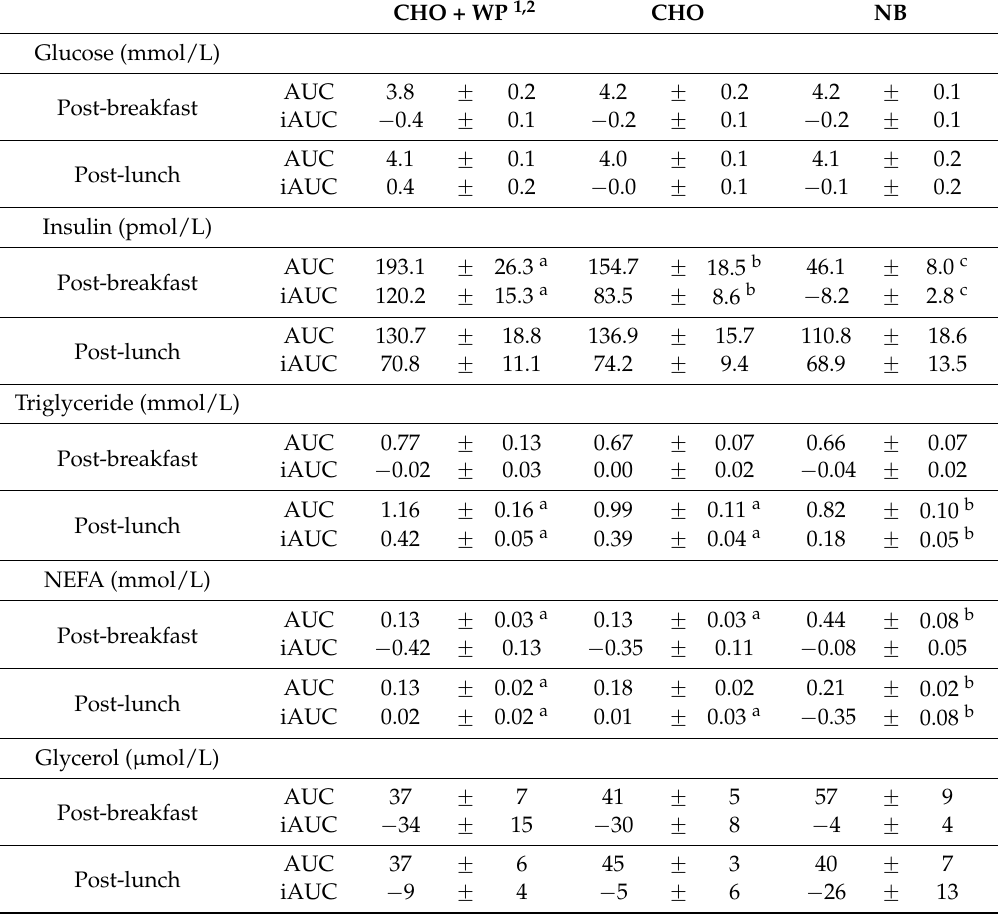
Table 2. Time-averaged areas under the curve for blood and plasma variables during post-breakfast and post-lunch postprandial periods. CHO + WP 1,2 Glucose (mmol/L) Post-breakfast